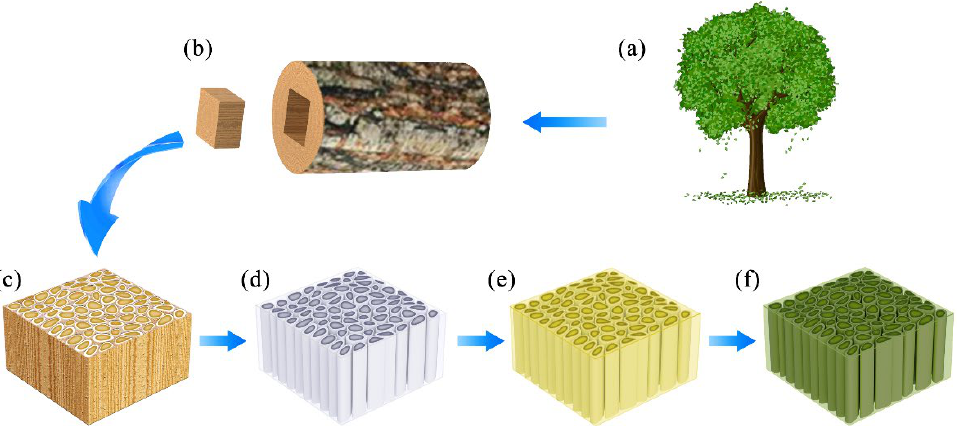
Figure 1. The preparation process of FUW: ( a ) tree; ( b ) wood; ( c ) ORW; ( d ) delignified wood; ( e ) FUW before the photochromic process; ( f ) FUW after the photochromic process.